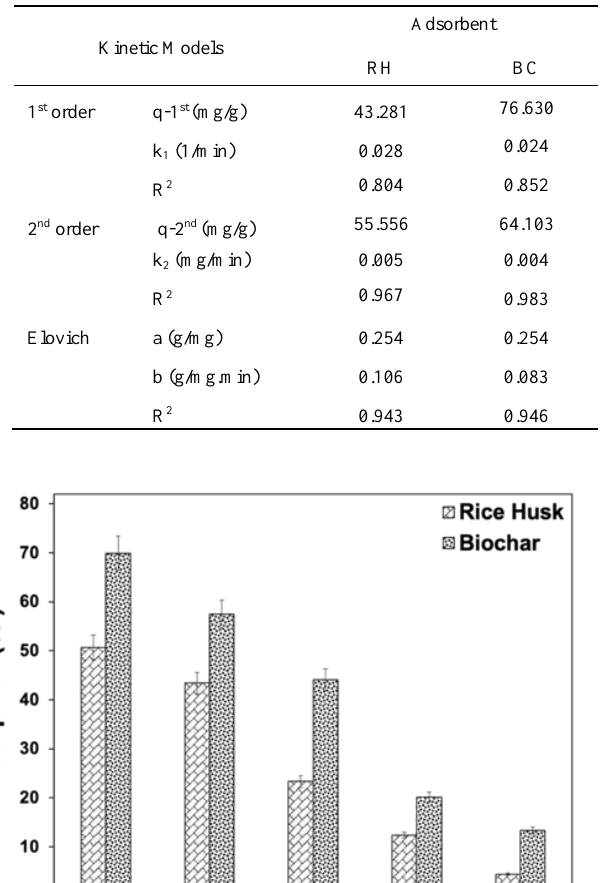
Table 4. Parameters of PFO, PSO, and Elovich models for RH and BC